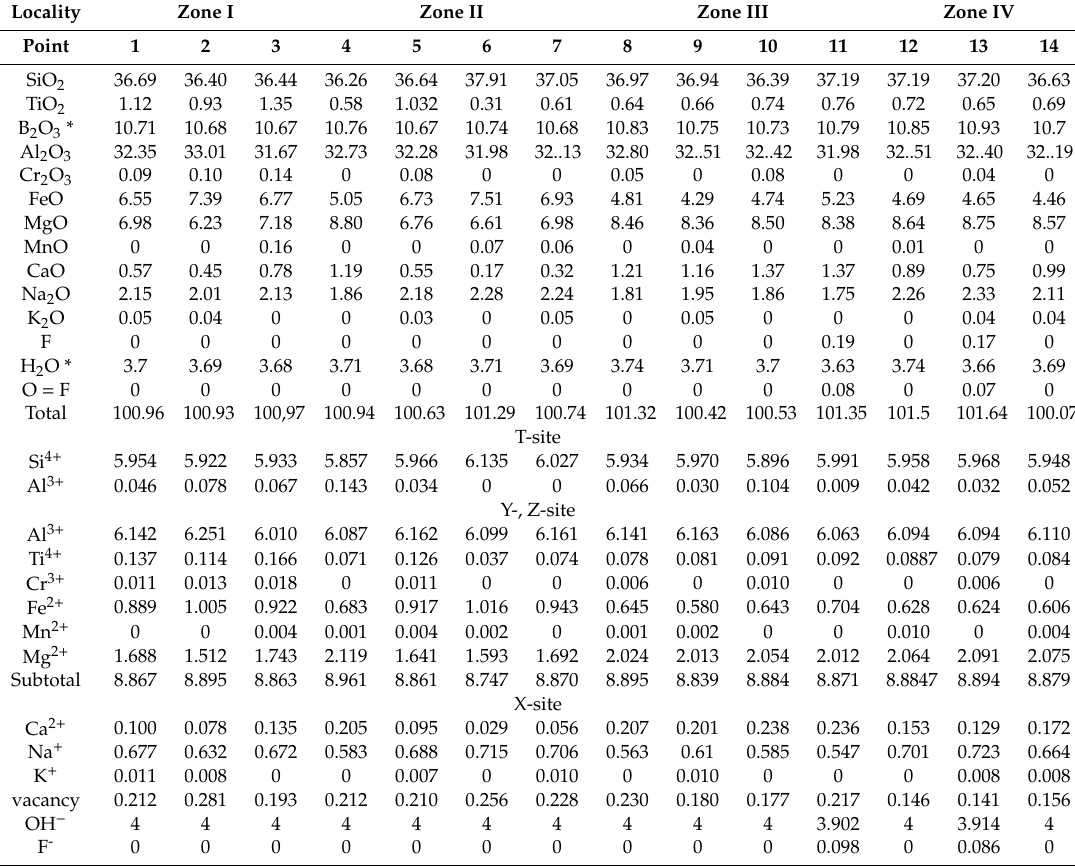
Table 2. Mineral chemistry of distinguished zones (I–IV) in multistage tourmaline grain from Glan ó